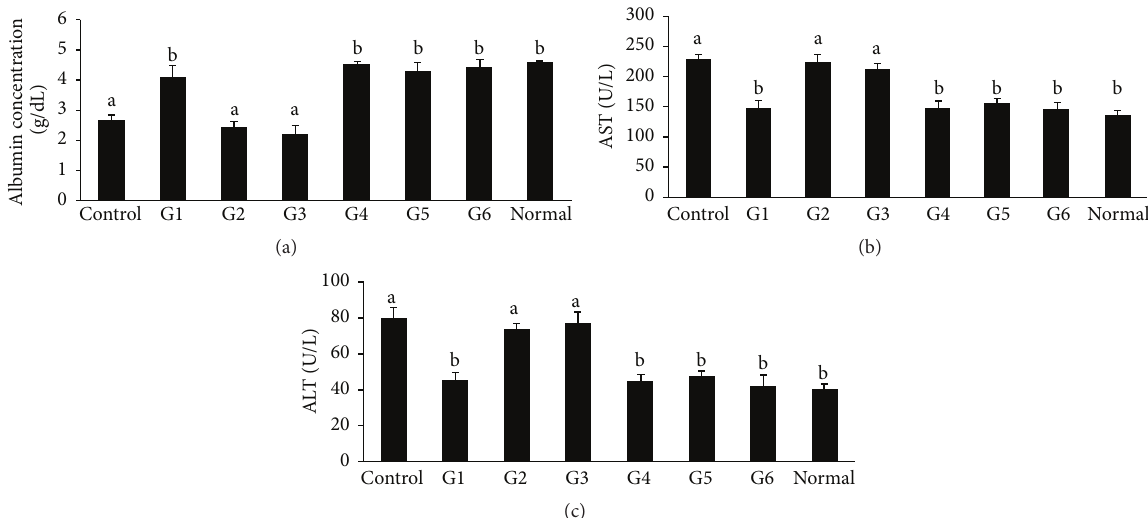
Figure 4: Biochemical analysis of blood sera. (a) Concentration of albumin (ALB), (b) aspartate aminotransferase, and (c) alanine transaminase (ALT) in blood serum of each experimental group. Bars with different superscripts are different statistically ( 𝑝 < 0.05 ). a , b 𝑝 < 0.05 , b , c 𝑝 < 0.05 . DMN-injured rats were considered as control